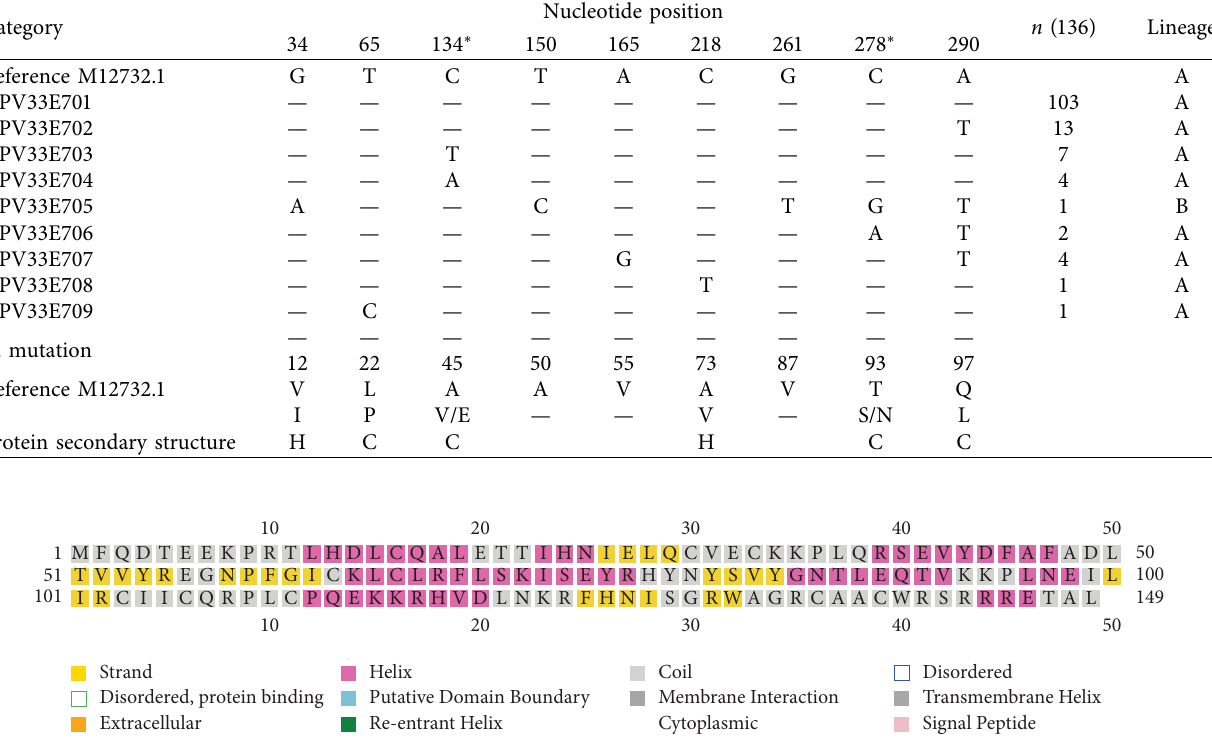
Figure 4: Te secondary structure of HPV33 E6